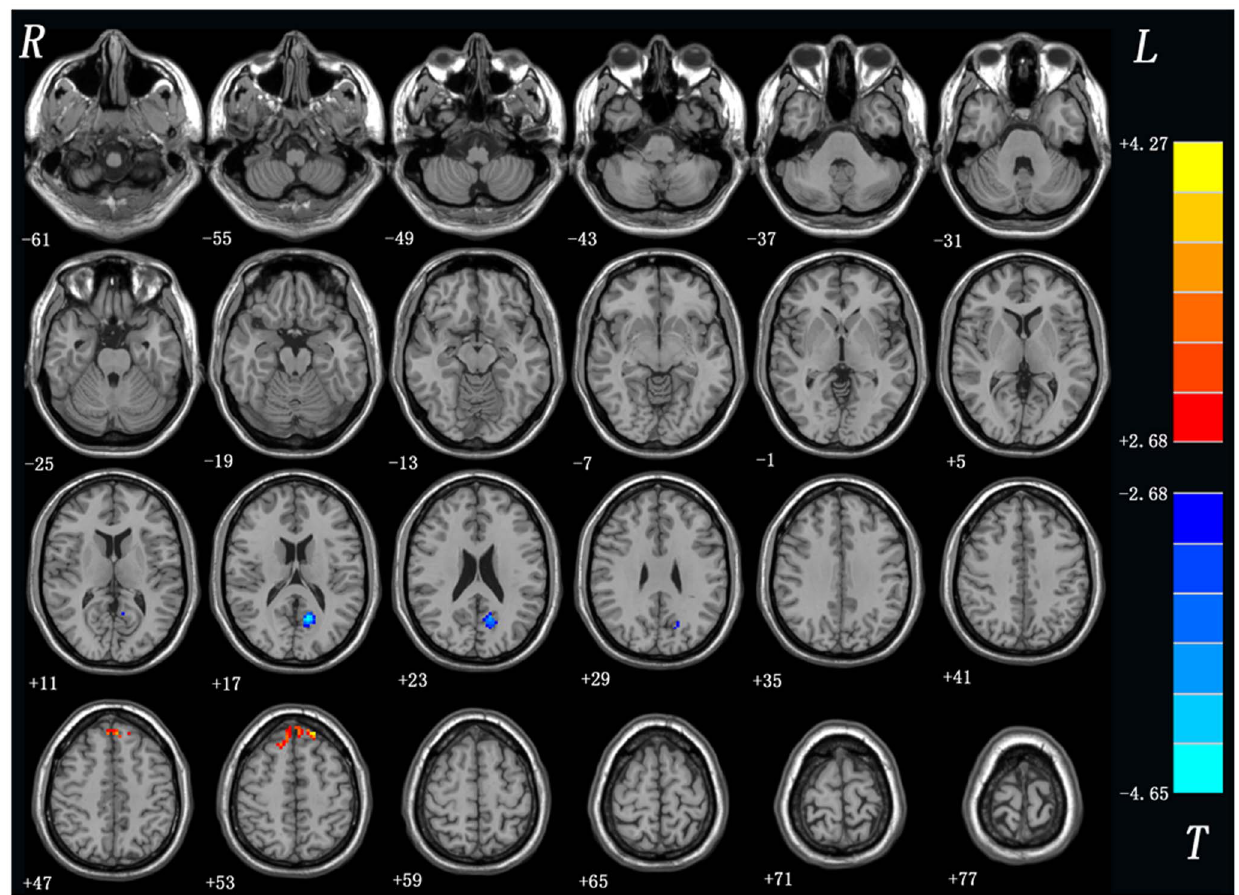
Figure 2. fALFF differences between the patients with SD and the controls. Red and blue denote higher and lower fALFF respectively and the color bars represent the t value of the group analysis. fALFF=fractional amplitudes of low-frequency fluctuations; SD=somatization disorder.